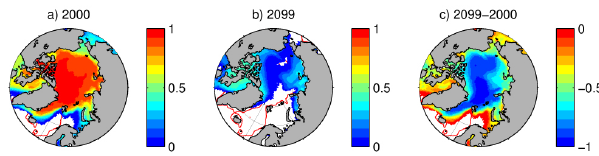
Fig. 2. Arctic Ocean annual mean ice concentration for year 2000 (a) , 2099 (b) , difference between year 2099 and 2000 (c) . The red line on this and subsequent Arctic plots shows 500m bathymet- ric contour.